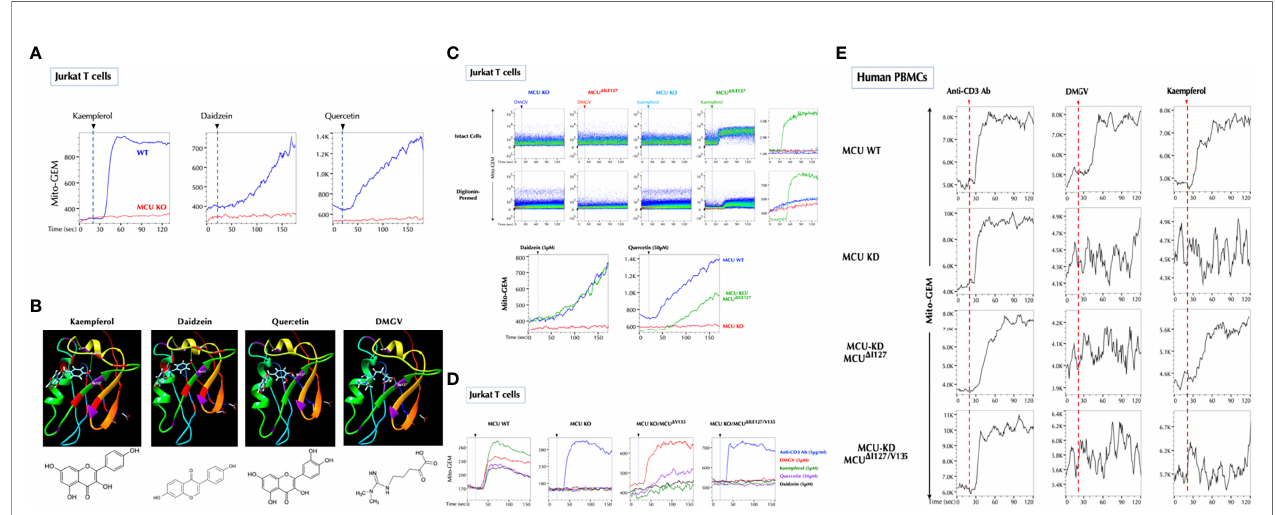
FIGURE 4 | Ile127 is essential for DMGV to activate MCU. (A) The fl avonoids induce calcium in fl ux to the mitochondria via MCU. Control and MCU-KO Jurkat cells expressing Mito-GEM-GECO were treated with kaempferol (5µM), daidzein (5µM), or quercetin (50µM), and mitochondrial calcium fl ux (Mito-GEM) was measured by fl ow cytometry. (B) SwissDock predicts that the fl avonoids and DMGV bind to MCU forming H-bonds to Ile127 and/or Val135. (C) DMGV no longer induces calcium through MCU D ile127 mutant. The MCU D ile127 mutant was transfected to MCU-KO Jurkat cells expressing Mito-GEM, and DMGV (5µM)-, kaempferol (5µM)-, daidzein (5µM), or quercetin (50µM)-induced mitochondrial calcium in fl ux was measured. To measure the calcium fl ux in the cell-free system, the same set of cells were permeabilized with 50µM digitonin for 2min before the measurement. (D) Val135 is essential for the full activation by the fl avonoids to induce calcium fl ux via MCU. MCU-KO Jurkat cells expressing Mito-GEM were transfected with MCU D val135 or MCU D ile127/Val135 mutant, and DMGV (5µM)-, kaempferol (5µM)-, daidzein (5µM), or quercetin (50µM)-induced mitochondrial calcium in fl ux was measured. Anti-CD3 Ab (5µg/ml) induced mitochondrial calcium in fl ux independently of MCU. (E) Human PBMCs were infected with Lentiviruses expressing Mito-GEM-GECO and next day electroporated with control plasmid + control siRNA, control plasmid + MCU siRNA, MCU D ile127 plasmid + MCU siRNA, or MCU D ile127/Val135 plasmid + MCU siRNA. The following day, the cells were treated with anti-CD3 Ab (5µg/ml), DMGV (5µM), or kaempferol (5µM). All above data were repeated at least twice in similar settings with similar